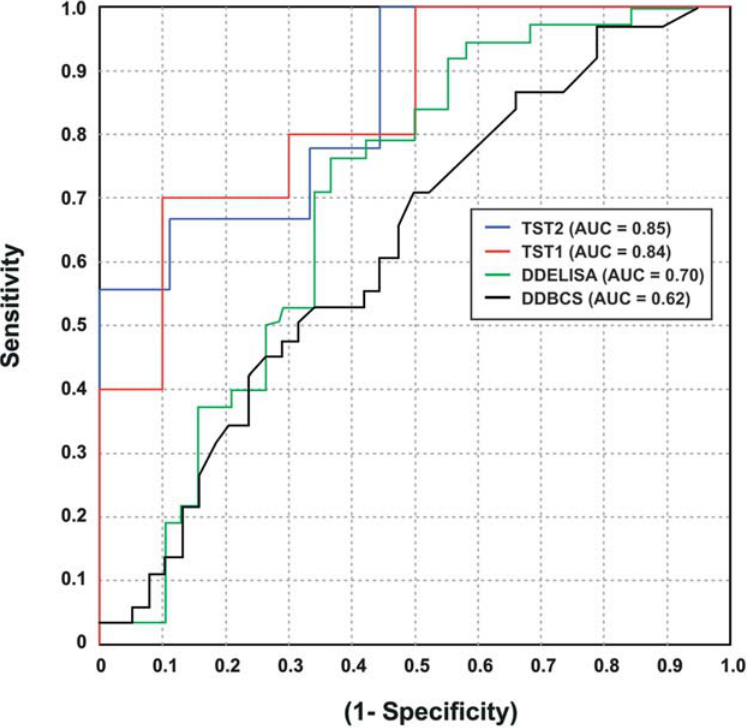
Figure 3. ROC characteristics for the direct MS method in the independent test set compared to standard D-dimer tests. The optimized model shows comparable ROC curves in test set 1 (TST1) and test set 2 (TST2). D-Dimer by ELISA and immunoturbimetric assay results are plotted for all 76 patients in the cohort for comparison.